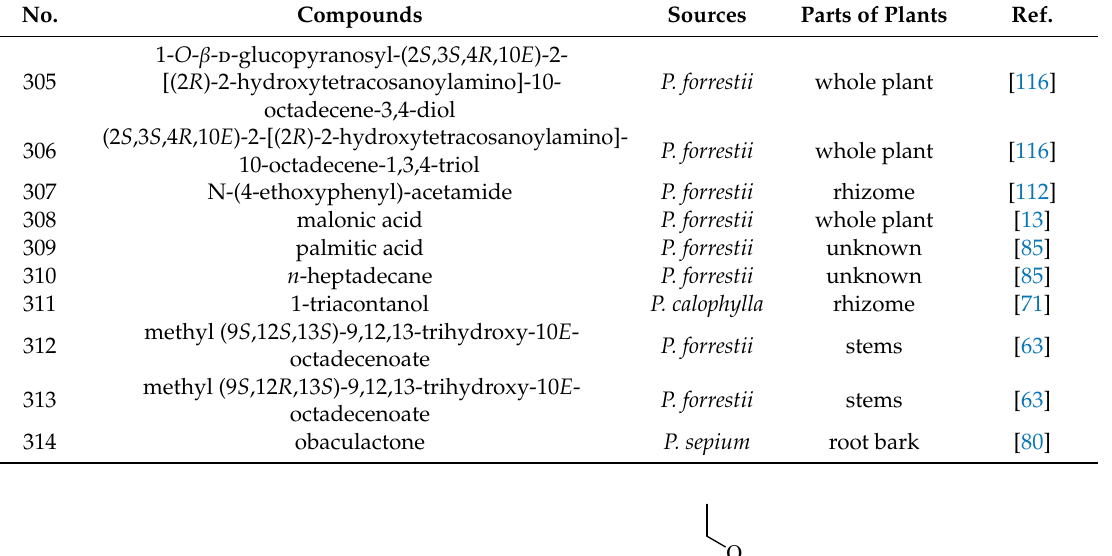
Table 9. Other compounds from the genus Periploca .